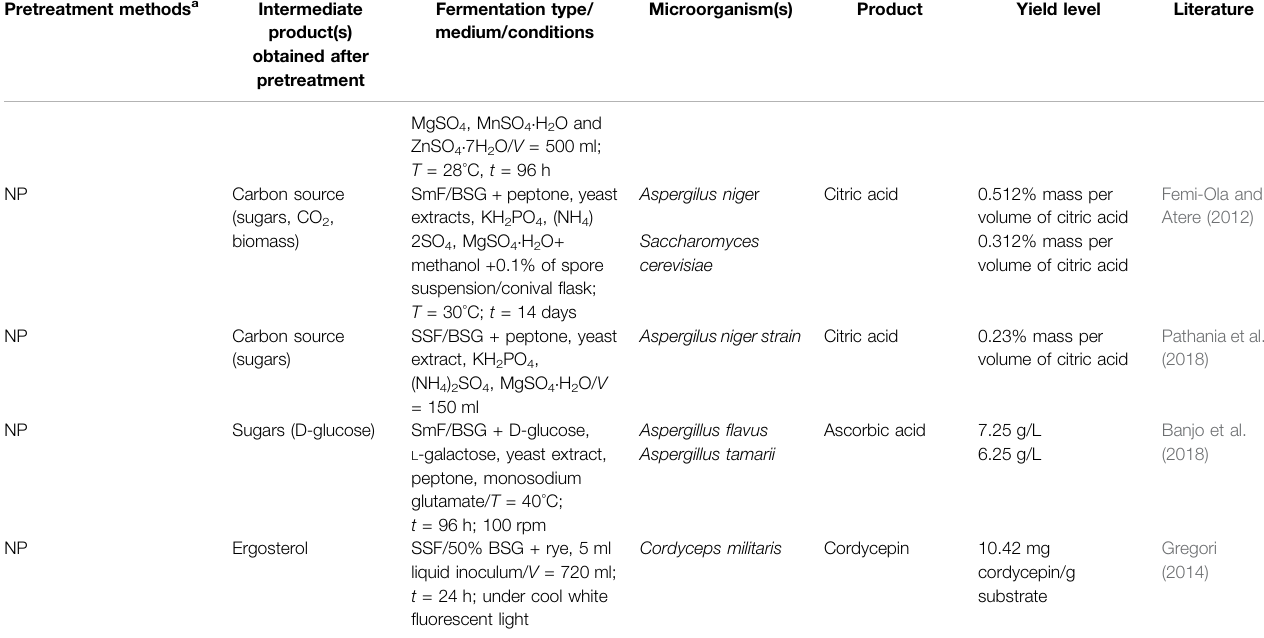
TABLE 4 | ( Continued ) Production of value-added products from BSG